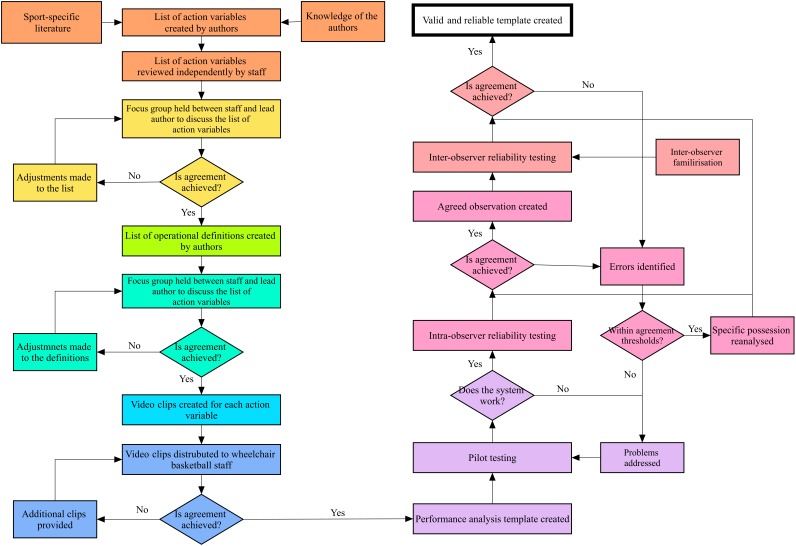
Diagram showing the systematic research process for developing a new performance analysis template [adapted from James et al. (2005) and Thomson et al. (2013)].